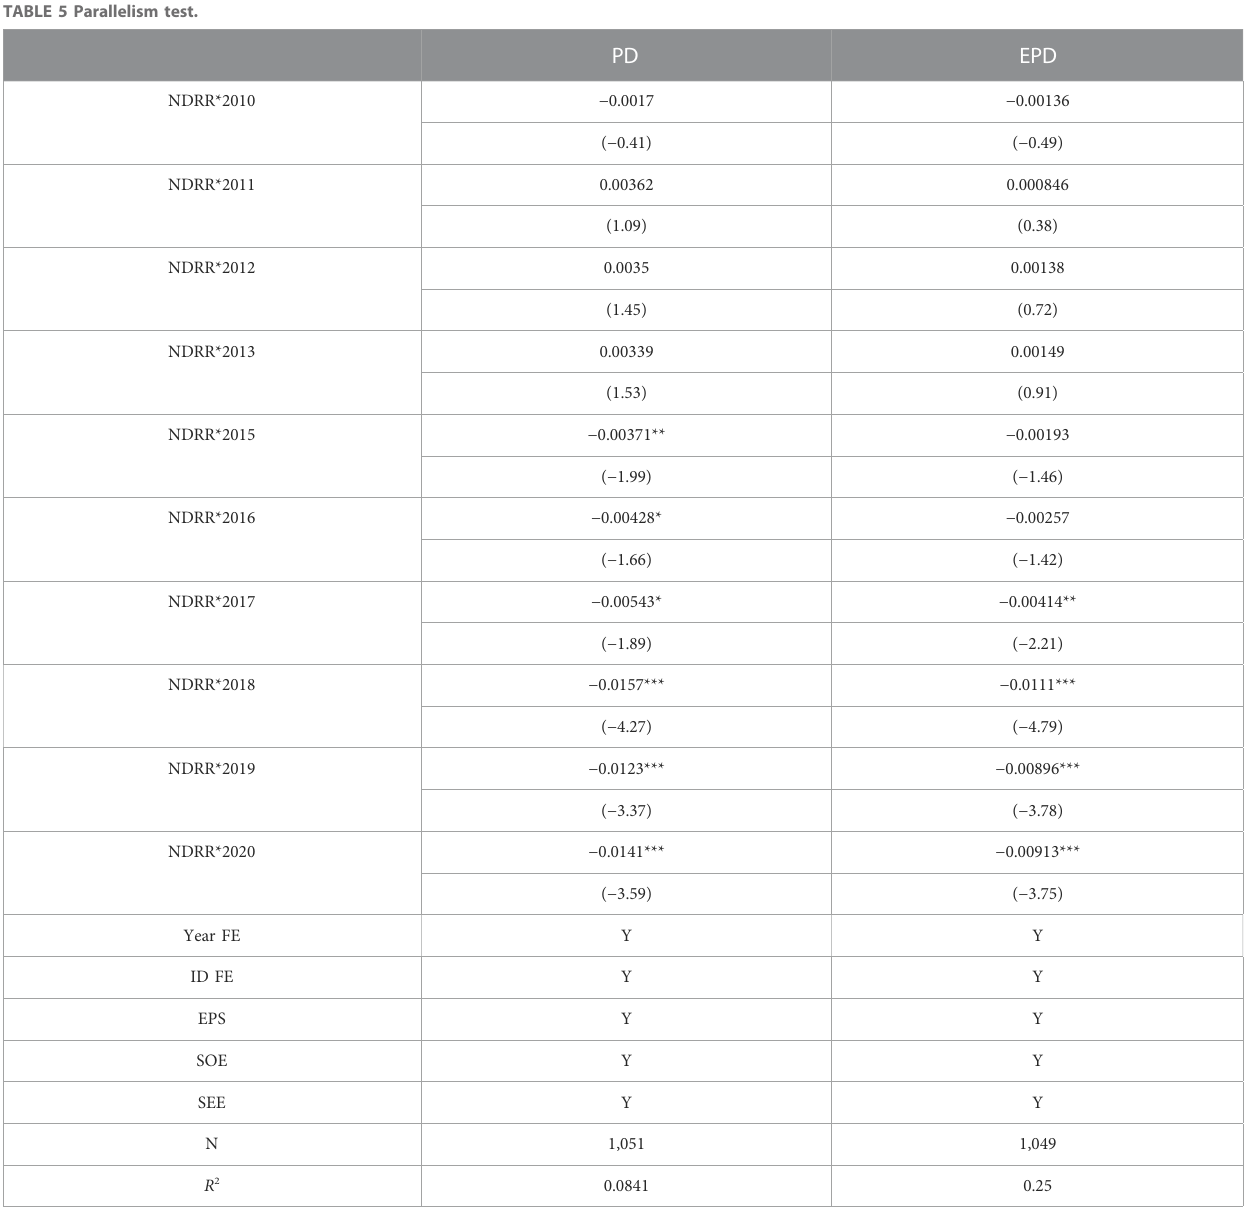
TABLE 5 Parallelism